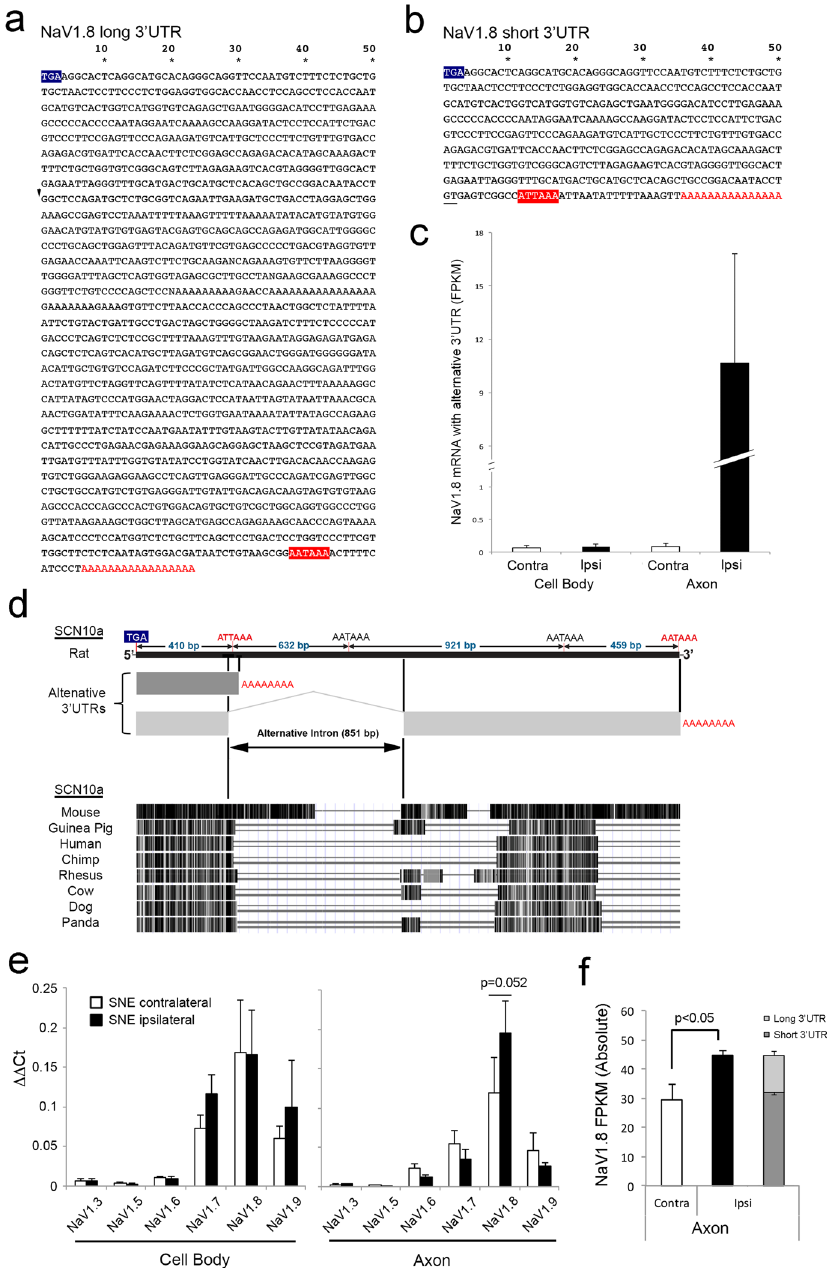
Figure 4. Molecular cloning and sequencing using a combination of targeted PCR and 3 ′ RACE identified the previously unreported long 3 ′ UTR sequence. ( a ) The NaV1.8 long 3 ′ UTR was composed of a 1603 nt-long sequence including the canonical polyA signal (red box) followed by a polyA tail. ( b ) The previously published short 3 ′ UTR sequences of NaV1.8 share the first 400 nucleotides with the newly discovered long 3 ′ UTR and then diverted, as GT in the short 3 ′ UTR (underline in b ) apparently served as the donor sequence of the alternative intron in the long 3 ′ UTR. ( c ) The use of the distal exon in the long 3 ′ UTR was normalized to the common domain between the long and short 3 ′ UTRs (mean ± SD). The presence of the long 3 ′ UTR appeared to be exclusive in the ipsi axon sample. ( d ) The Scn10a genomic structure revealed that the newly identified exon was separated by an intron (851 bp), alternative splicing of which resulted in the alternative polyadenylation sites. The search of gene sequences of different species suggested significant sequence homology in the domain encoding the short 3 ′ UTR as well as the newly identified alternative exon-intron junction. Furthermore, there was a highly homologous domain in the central part of the new exon encoding the extended part of the long 3 ′ UTR. ( e ) RNA samples used for RNA-Seq were examined for steady state mRNA level changes of NaV isoforms (mean ± SD). The NaV1.8 mRNA level tended to increase in the SNE-conditioned (ipsi) axon, although it did not reach statistical significance (p = 0.052). ( f ) RNA-Seq data were reanalyzed for NaV1.8 FPKM, which revealed that the increase of NaV1.8 mRNA levels in the SNE-conditioned (ipsi) axons was contributed by NaV1.8 mRNA with the long 3 ′ UTR (mean ±